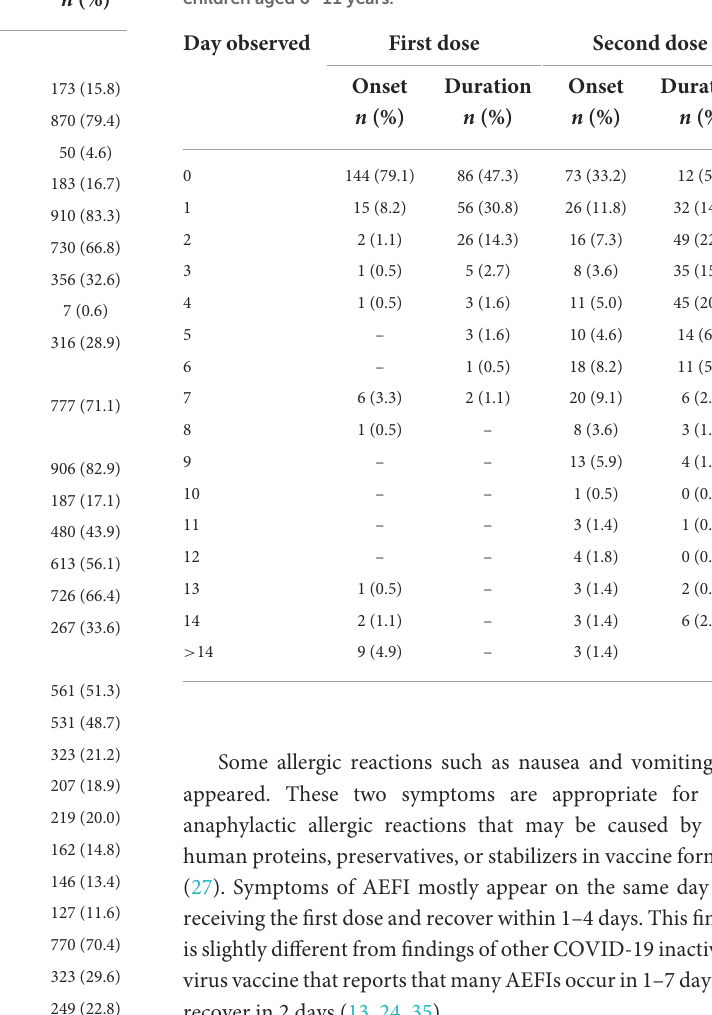
TABLE 1 Characteristics respondents and children. TABLE 2 Time observed of onset and duration of adverse event